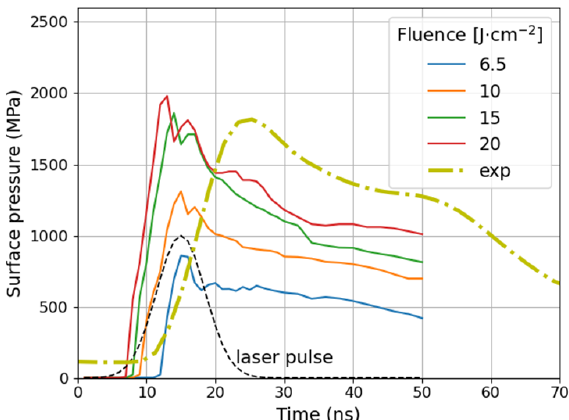
Figure 3. Evolution of surface pressure during 50 ns of plasma ablation process in confining medium (water) calculated in the model for fluences 6.5, 10, 15, and 20 J·cm − 2 . Experimental surface pressure labelled exp is also shown for a comparison. It was calculated from measurements as described in details in Section 3.2.